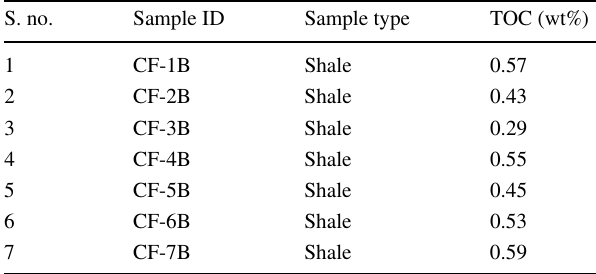
Table 3 The TOC results of outcrop samples of the Chichali Forma-